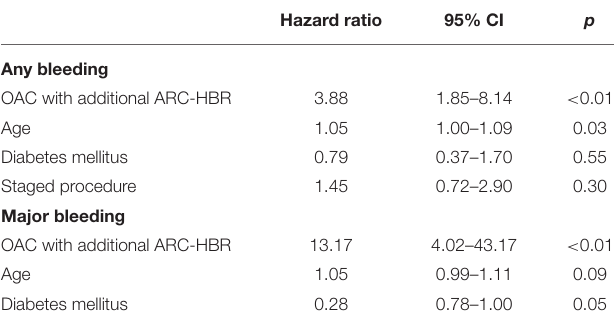
TABLE 5 | Adjusted clinical outcomes at 2 years of follow-up for primary and secondary bleeding